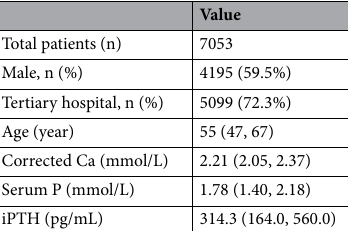
Table 1. The basic clinical information of MHD